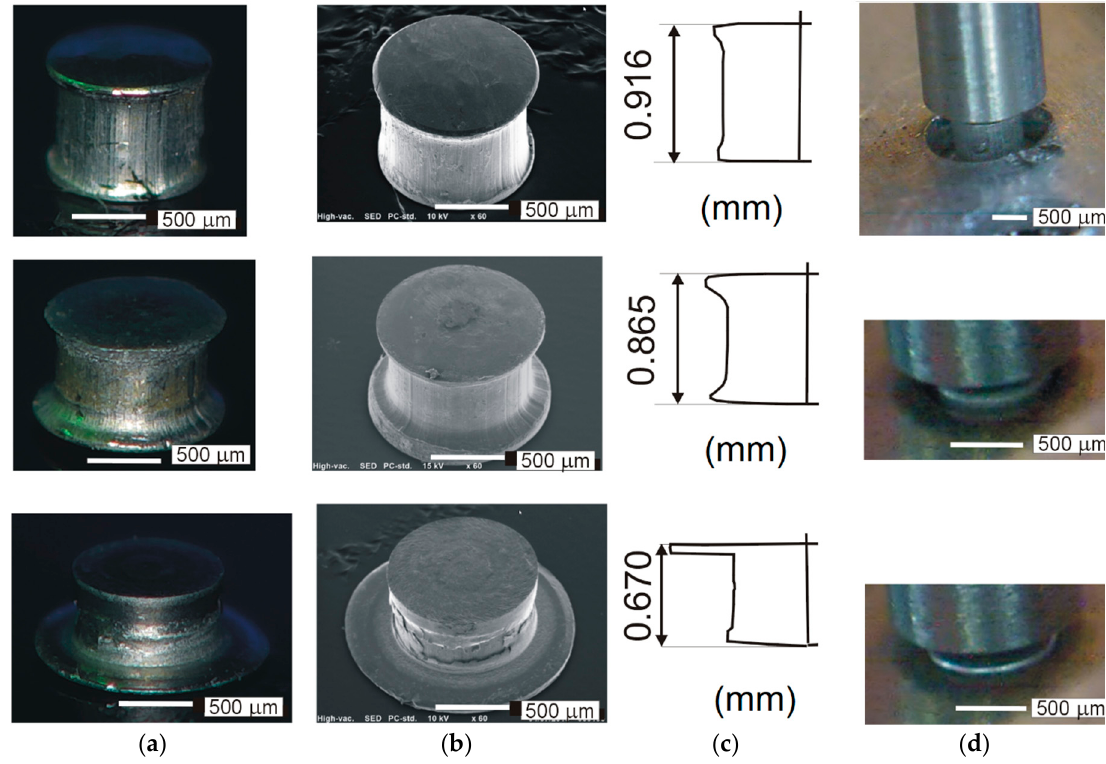
Figure 4. Specimens after ultrasonic upsetting: ( a ) pictures; ( b ) SEM; ( c ); outlines; and ( d ) sample frames from the recorded movie of the process.